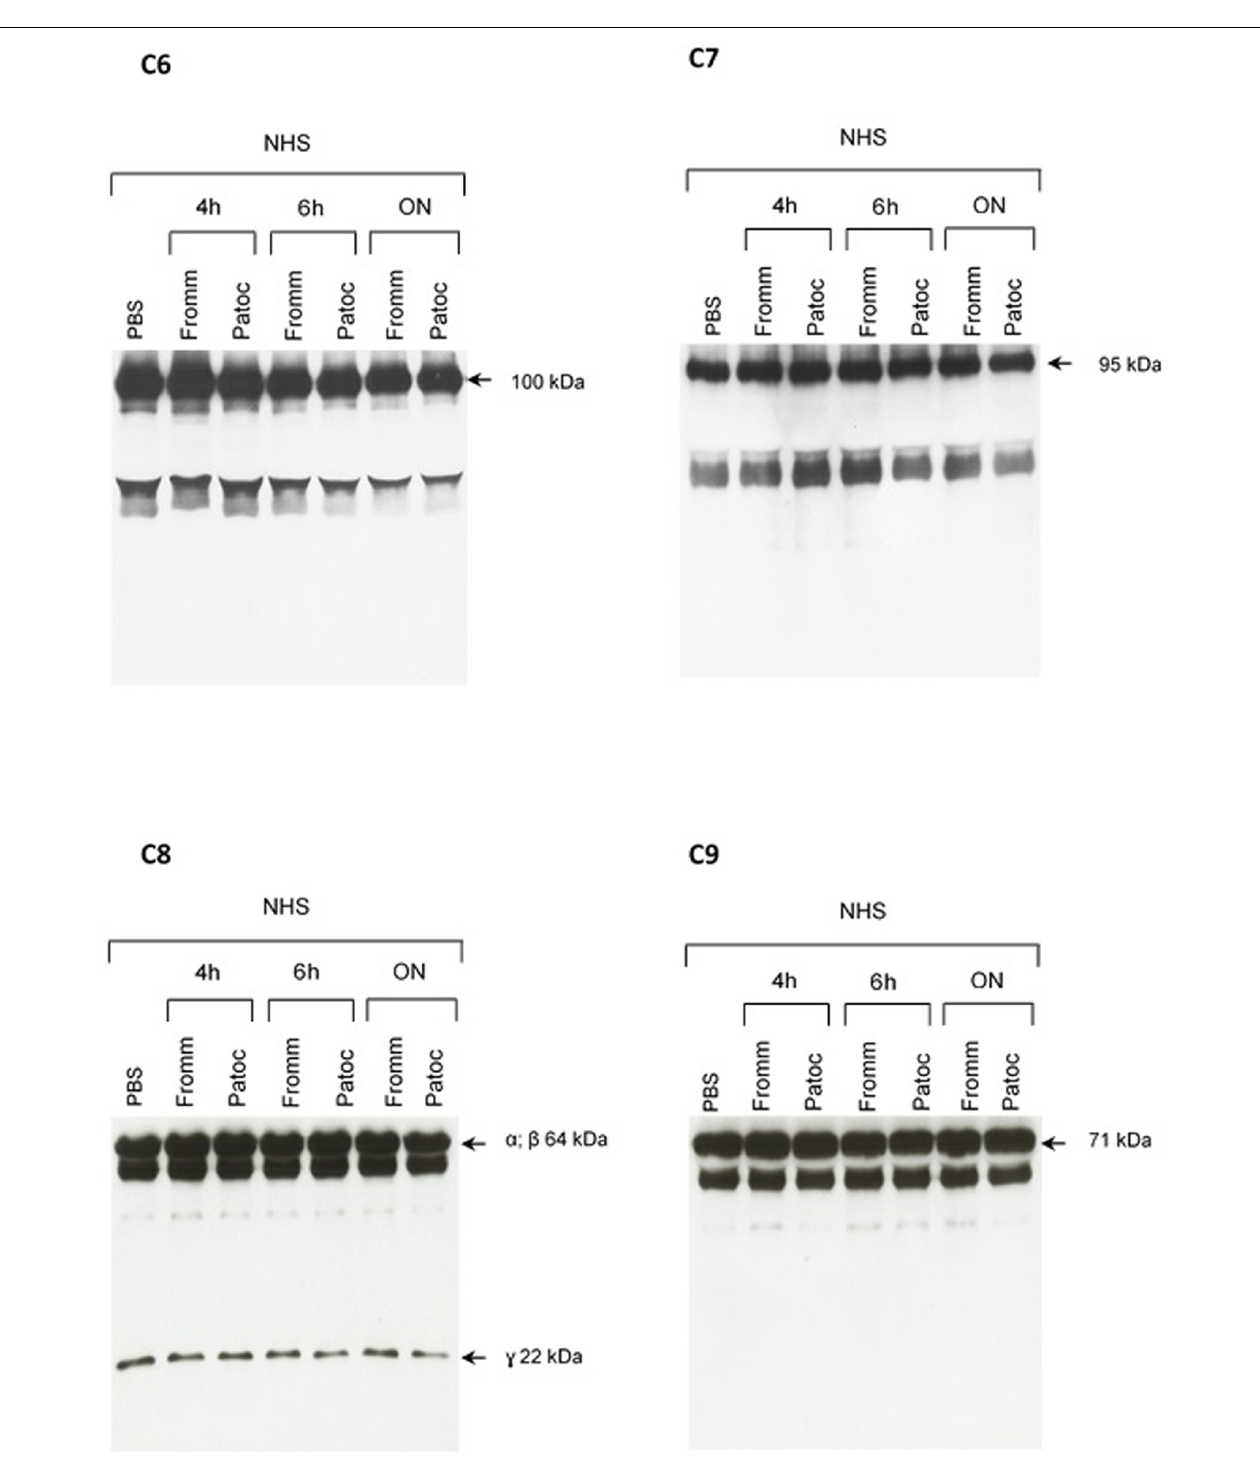
FIGURE 5 | Proteolytic activity of SPL or SNPL on C6-C9 proteins present in normal human serum. SPF from L. interrogans serovar Kennewicki strain Fromm and SNPL from L. biflexa serovar Patoc strain Patoc I were incubated with normal human serum (as a source of C6–C9 proteins; NHS) for 4 h, 6 h or overnight (ON). Normal human serum diluted only in PBS was used as a negative control. The cleavage fragments were analyzed by Western blot using specific polyclonal antibodies.